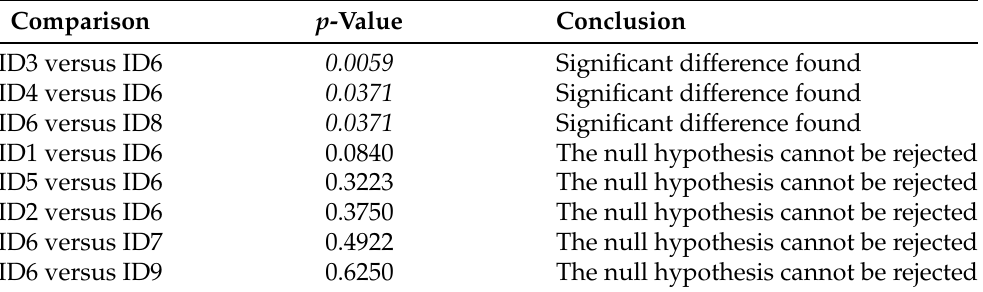
Table 11. p -values from Wilcoxon signed-rank